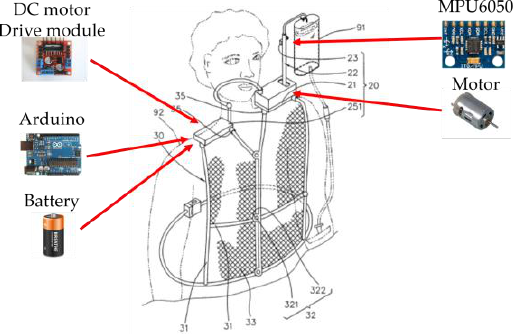
Figure 2. Carryable and automatically balanced intravenous drip frame.